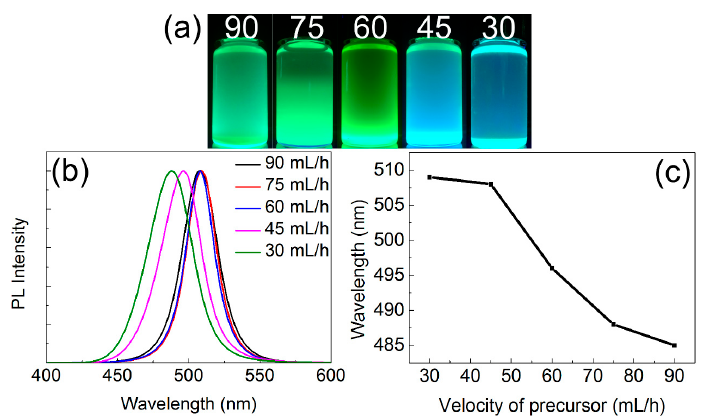
Figure A5. ( a ) Digital images under the UV light of 365 nm; ( b ) emission spectra; and ( c ) wavelength statistical chart of QDs-M with different velocity of precursor, where chloroform is used as nonpolar solvent. Materials 2018 , 11 , x FOR PEER REVIEW